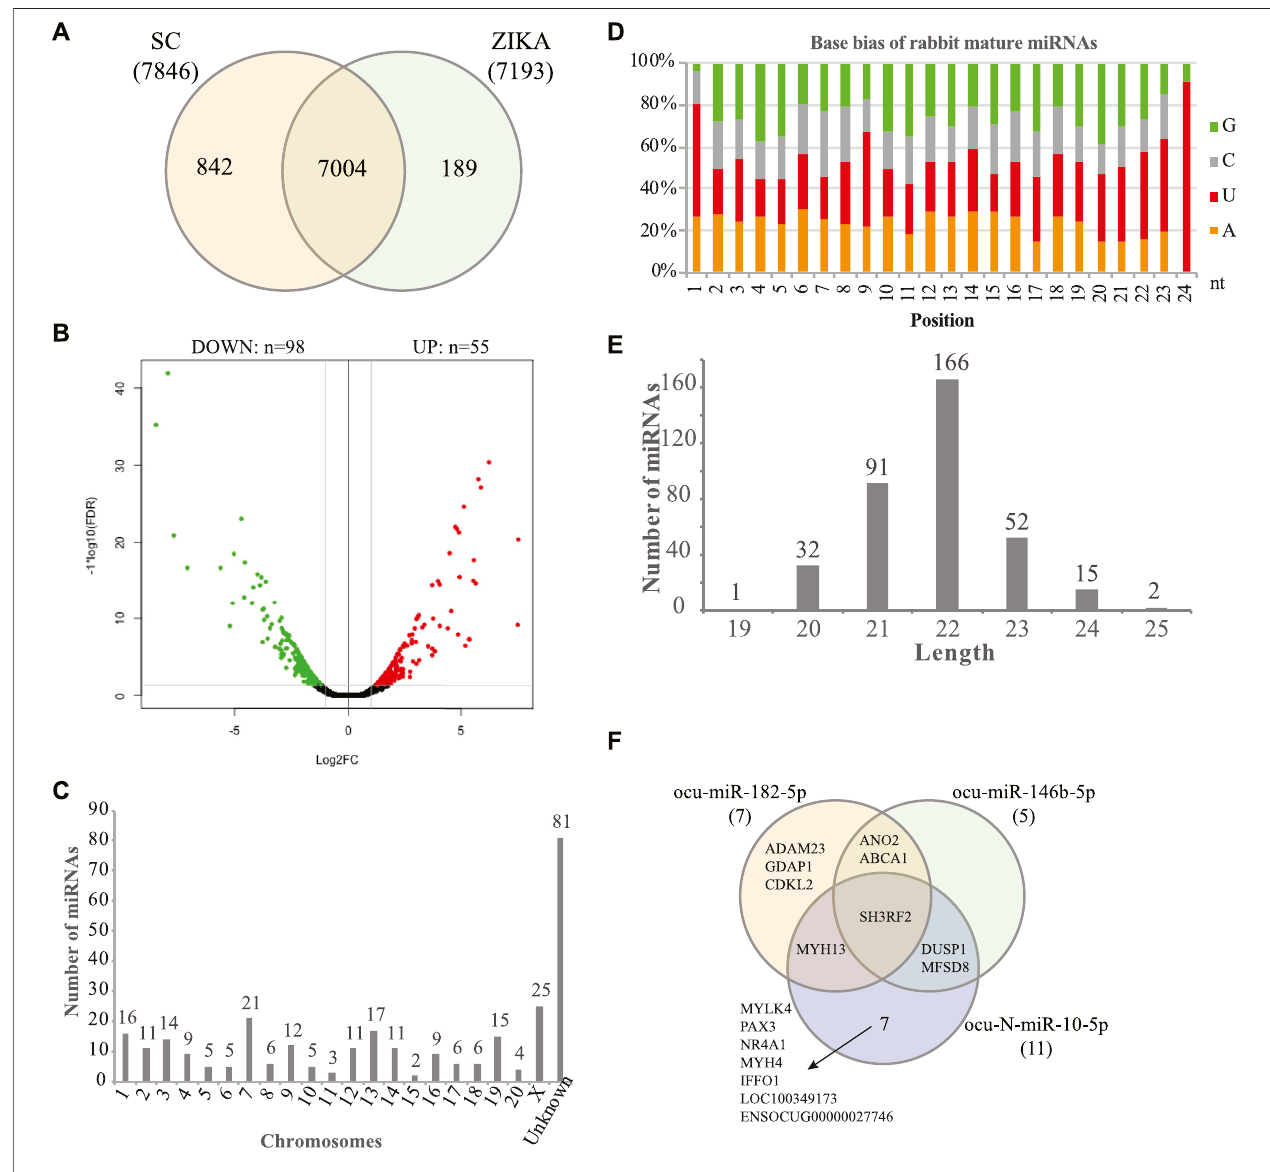
FIGURE 2 | Gene expression pro fi les and miRNAs identi fi ed in the muscle tissues of SCWrabs and ZIKArabs. (A) Venn diagram of genes identi fi ed in the muscle tissues of SCWrabs and ZIKArabs. (B) Volcano plot of differentially expressed genes in the muscle tissues of SCWrabs and ZIKArabs. (C) Distribution of miRNAs identi fi ed in the chromosomes of rabbit. (D) Base bias of the mature miRNAs identi fi ed in the muscle tissues of SCWrabs and ZIKArabs. (E) Length distribution of miRNAs identi fi ed in this study. (F) Comparison of target genes for the differentially expressed miRNAs.